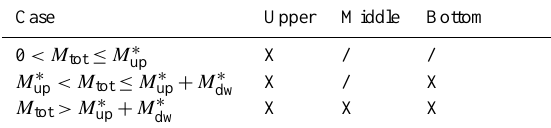
Table D2. Available processes in a layer and triggering condition.